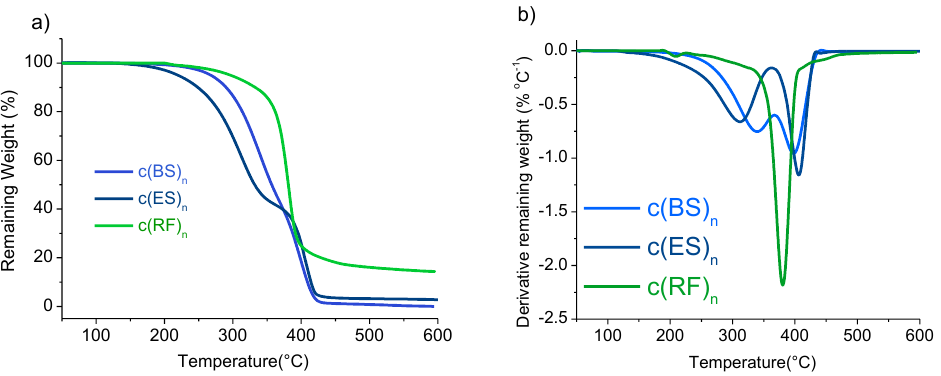
Figure 3. Compared TGA analysis of cyclic oligomers. ( a ) TGA traces; ( b ) Derivative curves showing temperatures at which degradation takes place at maximum rate.